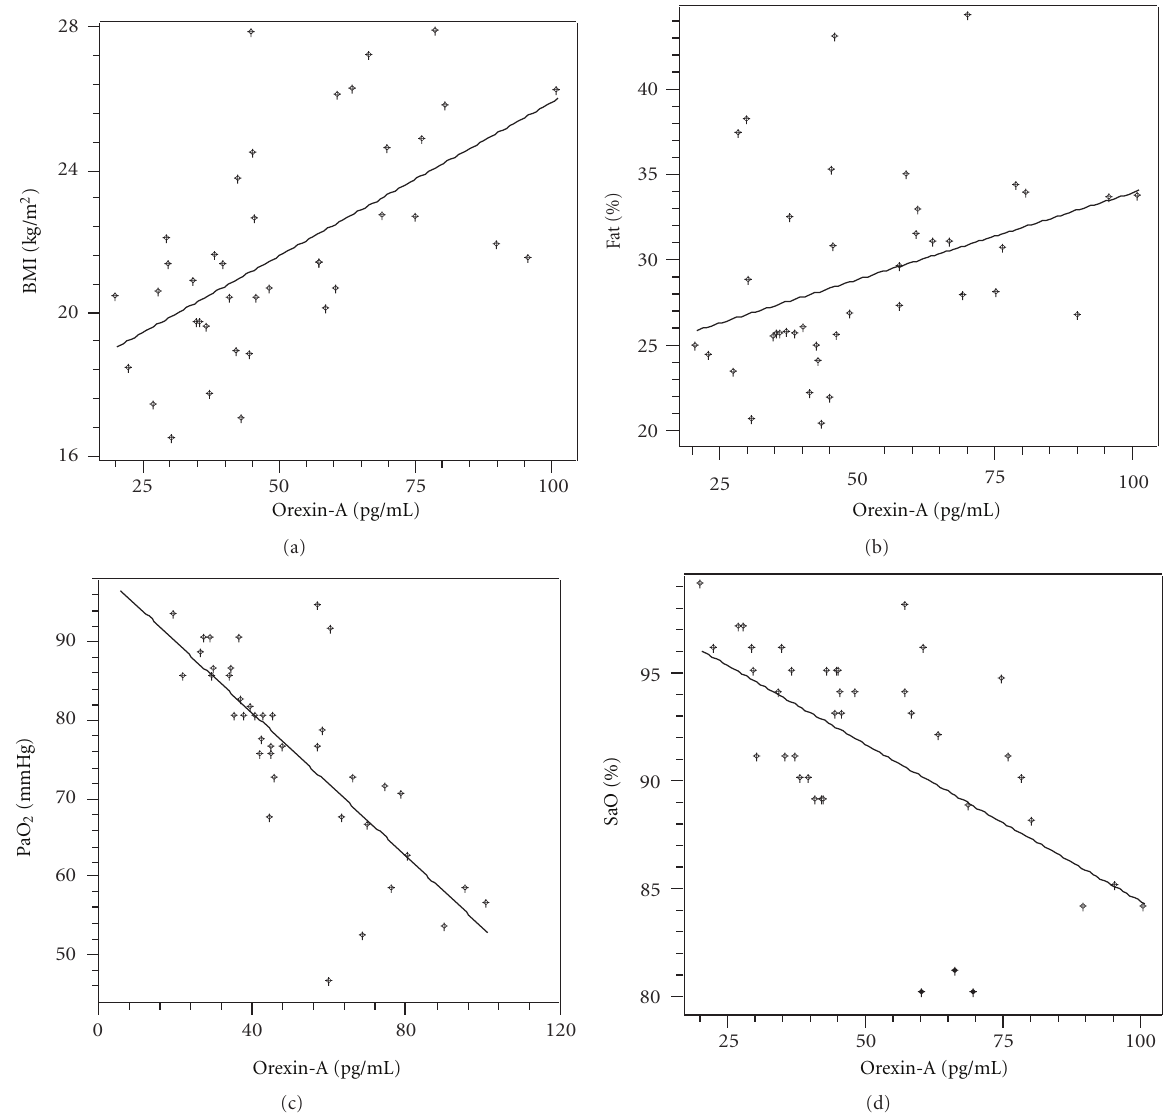
Figure 1: (a) Relationship between BMI and orexin-A. (b) Relationship between %fat and orexin-A. (c) Relationship between PaO 2 and orexin-A. (d) Relationship between SaO 2 and orexin-A. In patients with COPD, plasma orexin-A levels significantly correlated with BMI ( r = 0 . 589, P = . 000), %fat ( r = 0 . 367, P = . 020), PaO 2 ( r = − 0 . 738, P = . 000), SaO 2 ( r = − 0 . 616, P = .